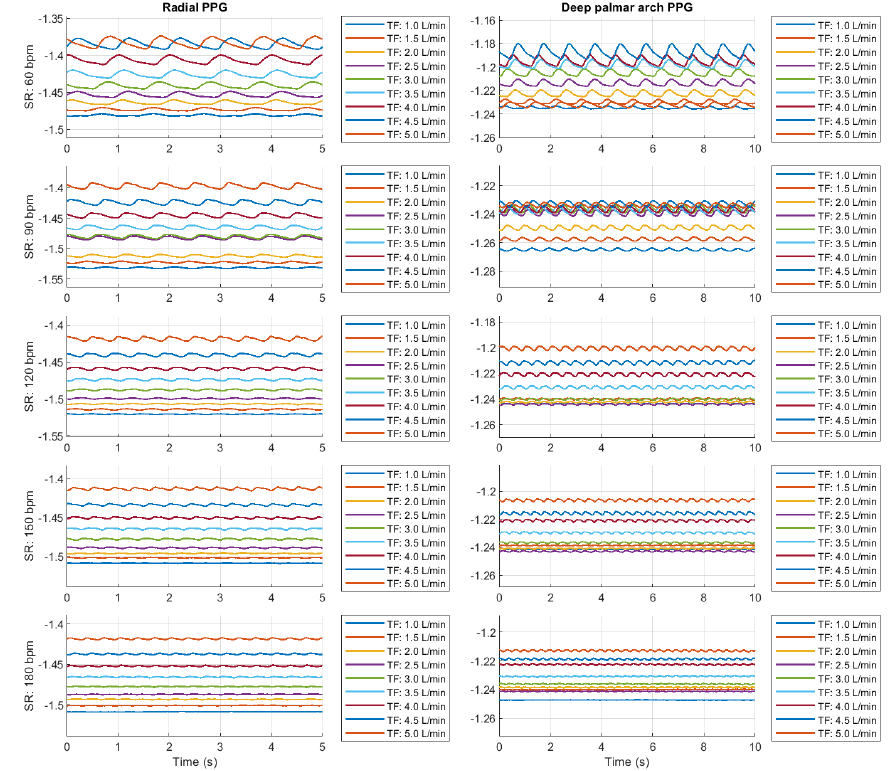
Figure 6. Example of photoplethysmographic (PPG) signals acquired from the constructed rig under different stroke rates and target